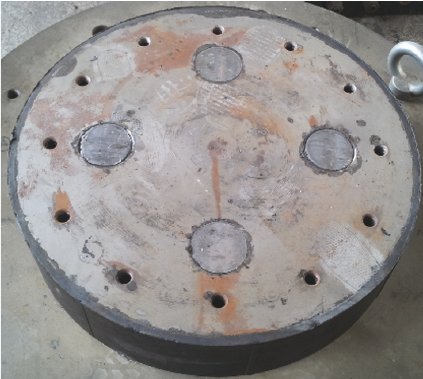
Figure 2: The lead rubber bearing in the